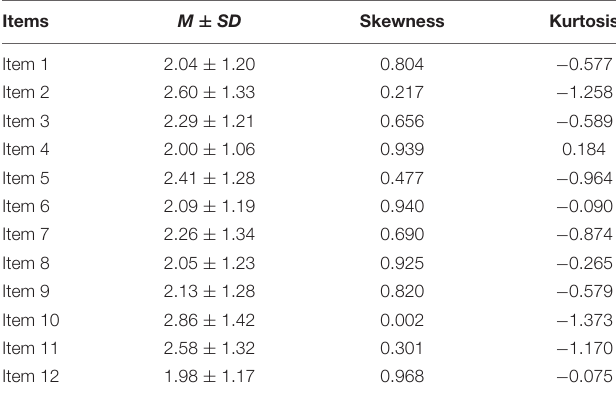
TABLE 1 | Descriptive statistics of negative problem orientation questionnaire in Chinese adolescents ( N = 754).